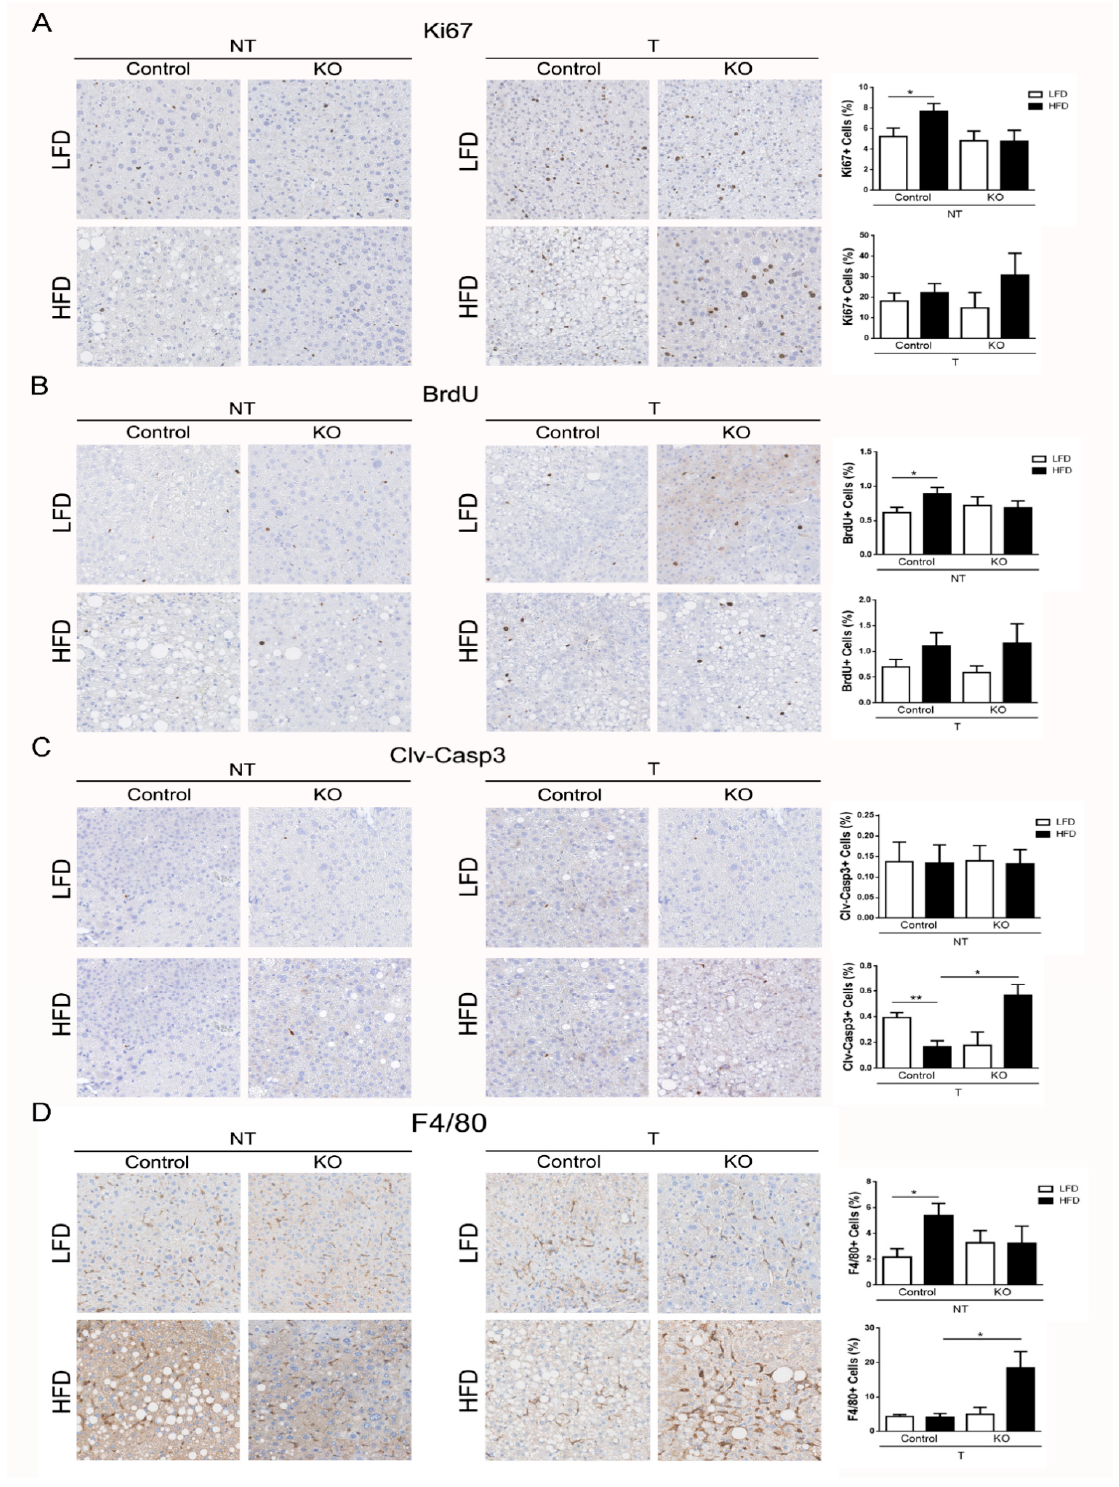
Figure 3. ARMCX3 deletion increases apoptosis and macrophage infiltration in hepatic tumors from HFD ‐ fed mice. Data correspond to liver sections from 7 ‐ month ‐ old f A3/Cre ‐ (Control) or ARMCX3 ‐ KO mice treated with DEN and maintained on LFD or HFD. Representative liver sections from non ‐ tumor (NT) and tumor (T) sections (left) and quantifications (right) of immunostaining for Ki67 ( A ), BrdU ( B ), cleaved caspase ‐ 3 ( C ) and F4/80 ( D ). Data are means ± SEM of 2–8 mice. Two ‐ Way ANOVA test with Tukey post hoc correction was used. * p ≤ 0.05 and ** p ≤ 0.01. Magnification: 13×.